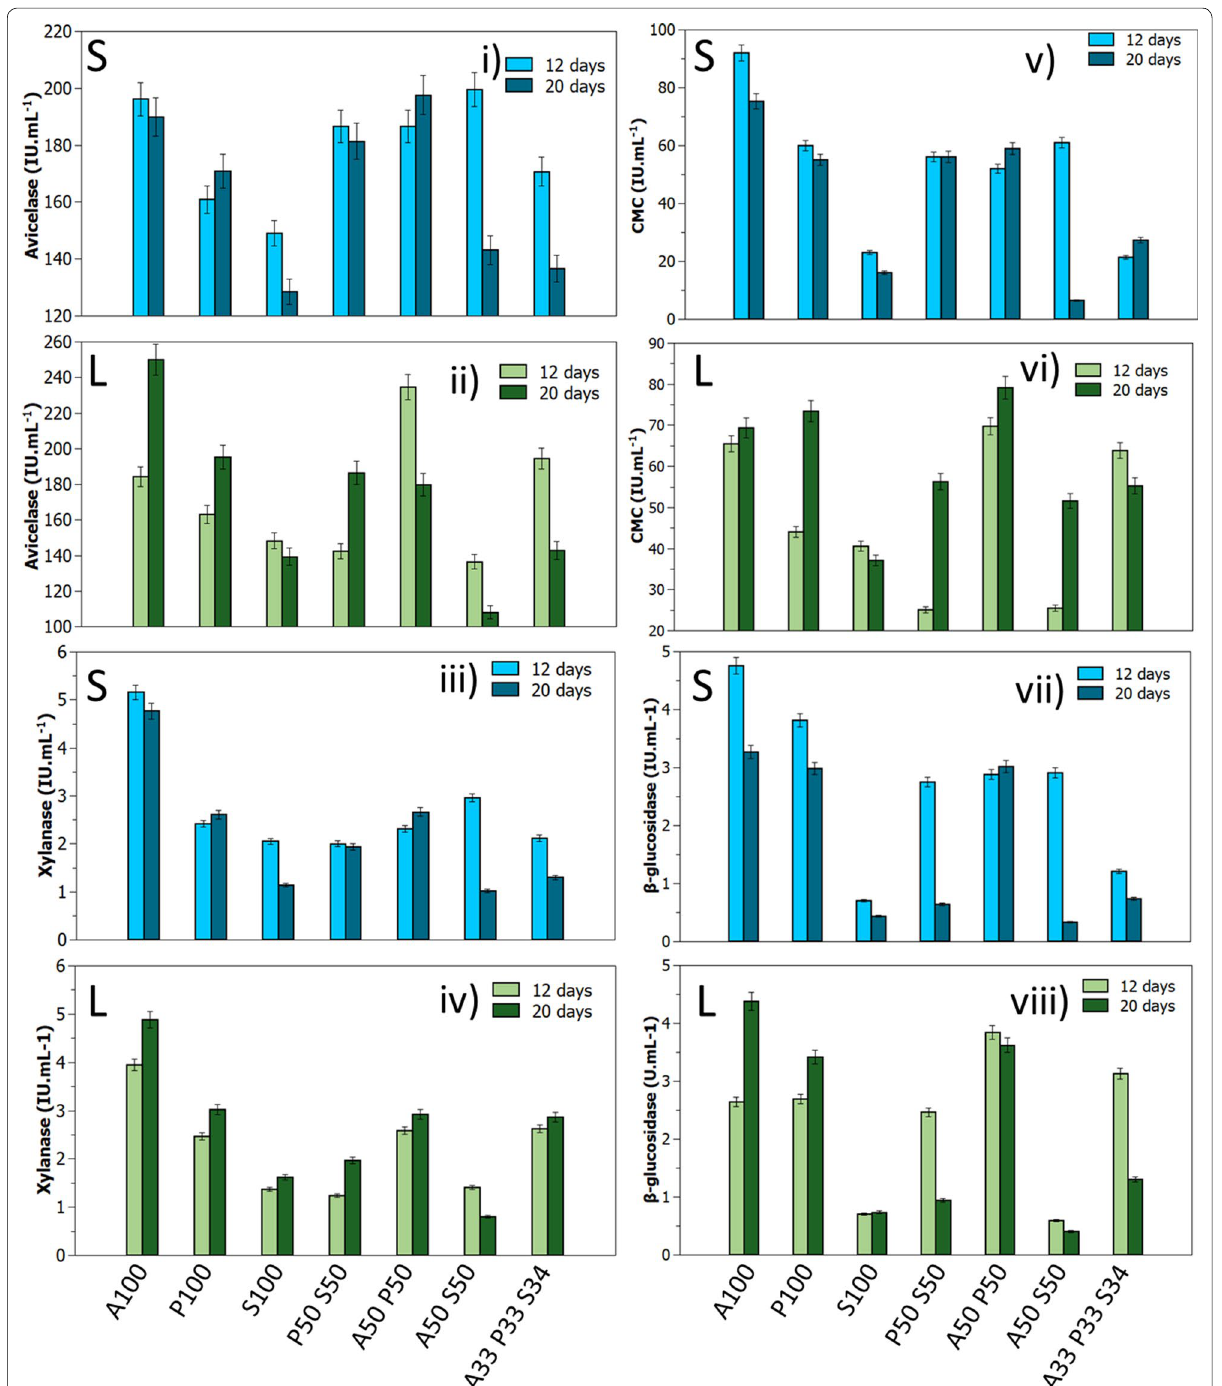
Fig. 2 Enzymatic activities of avicelase (i–ii), xylanase (iii–iv), CMC (v–vi), and β-glucosidase (vii–viii) using a solid or liquid inoculum at two studied time intervals (12 and 20